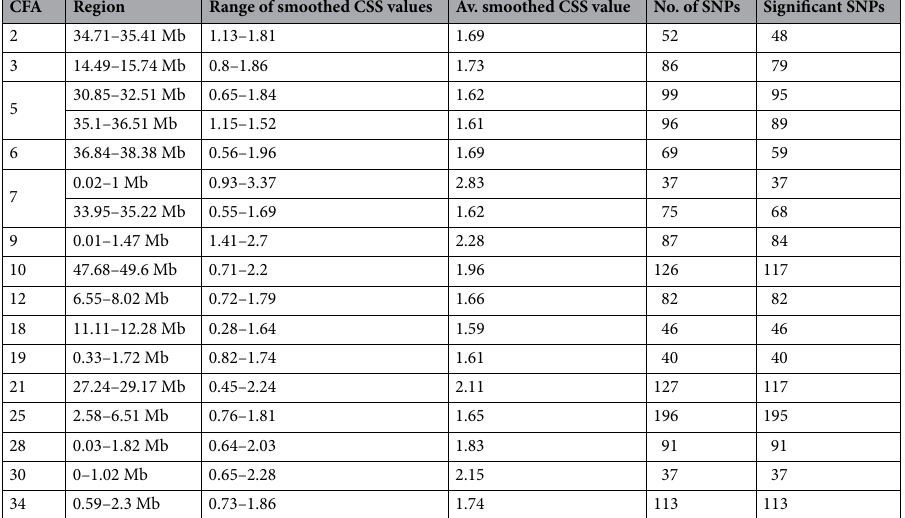
Table 2. Selected genomic regions in Qinghai-Tibetan Plateau dogs adapted to high